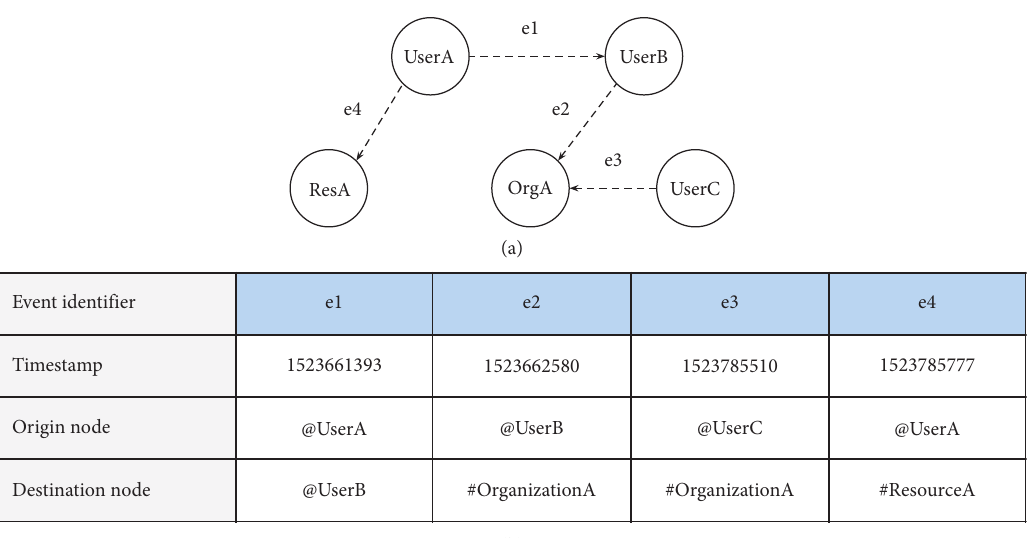
Figure 4: A sample of data points resulting from the event mining (b) and their corresponding snapshot ( G network (a), in which the interactions are binary (hence the lack of interactive event type i c ). Source: own